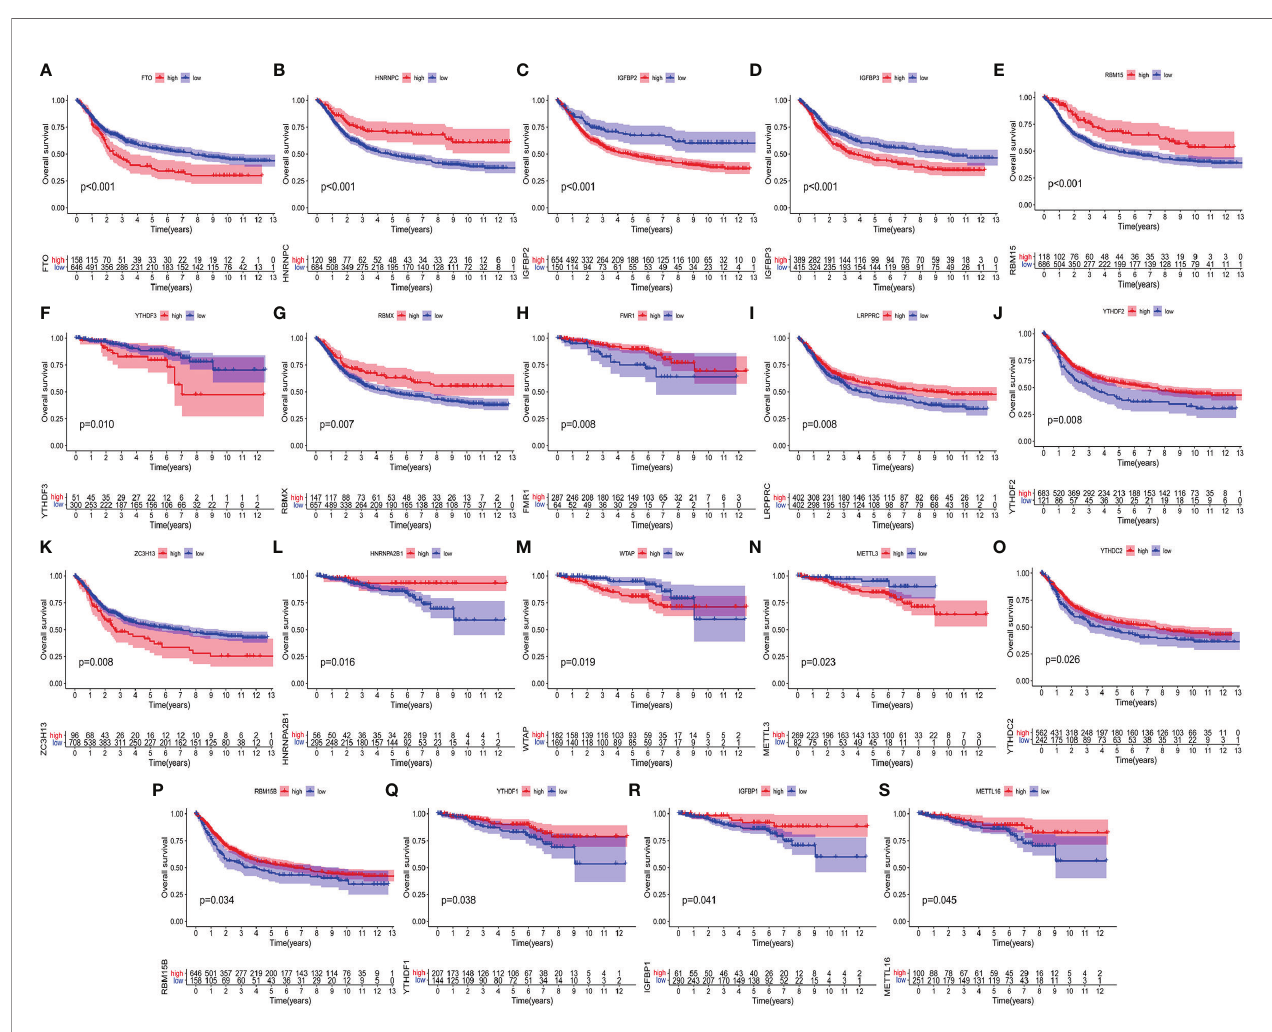
FIGURE 2 | Kaplan-Meier curves of 19 m 6 A regulatory factors in patients with rectal cancer. (A – S) Each fi gure represents the comparison of the overall survival in patients with higher and low expression of a speci fi c gene and the gene name is shown in the top of each fi gure. The ordinate shows the survival probability and the abscissa shows the years of survival of the patients. The number of patients in high- and low-expression groups are shown in the bottom of each fi gure. Log-rank test P<0.05 indicates that the difference is statistically signi fi